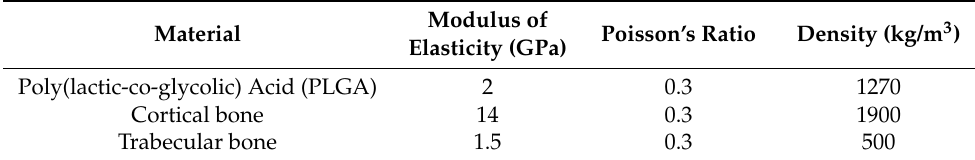
Table 2. Mechanical properties assigned for finite element method (FEM) analysis.